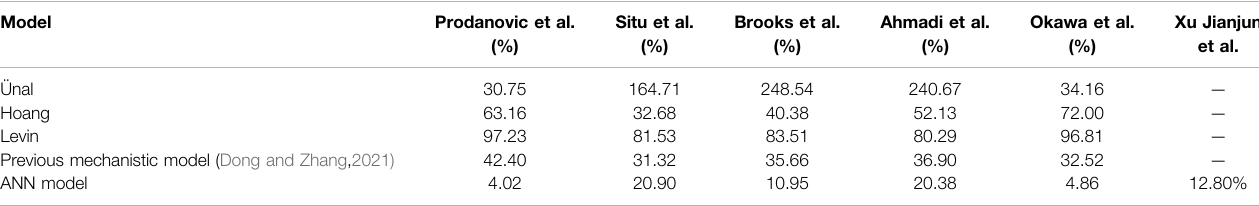
TABLE 3 | Arithmetic-mean errors of different models for the databases.